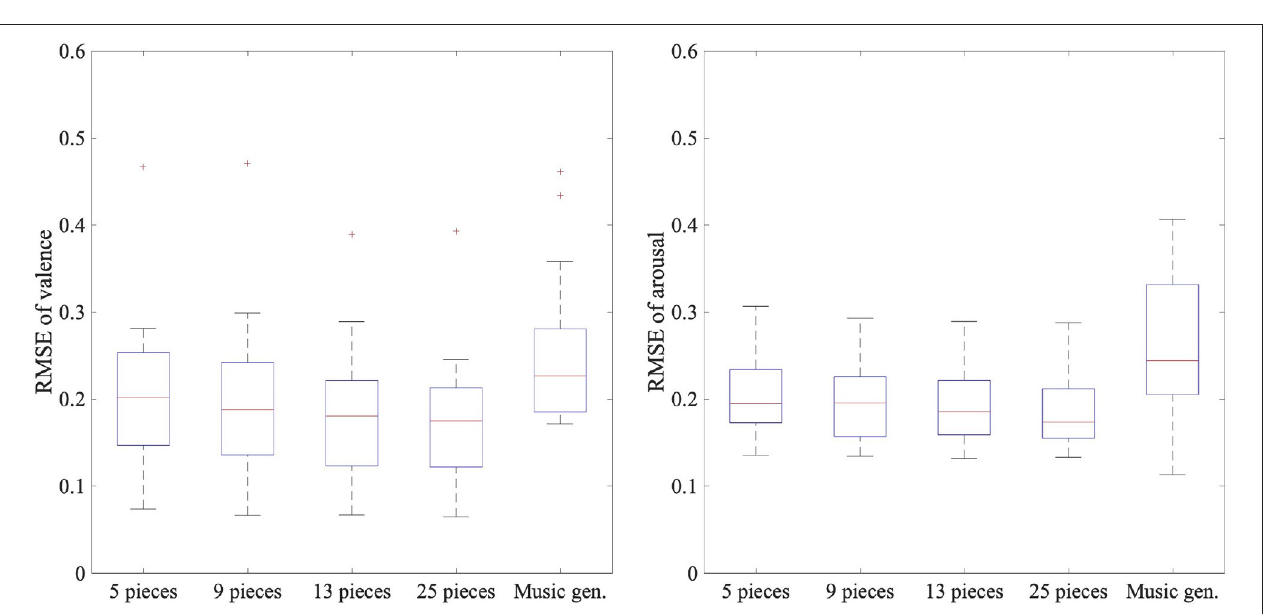
FIGURE 4 | Box plots of 20 participants’ RMSEs of felt and predicted emotions using EEG data and music generator’s inputs: Music gen. indicates emotion prediction using music generator’s